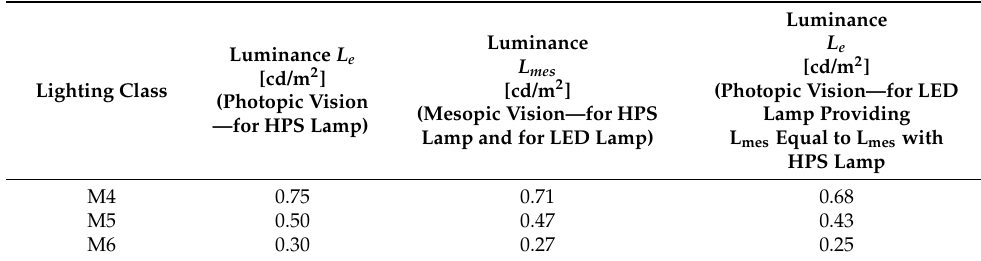
Figure 10. The human eye SPDs ratio for HPS to LED at different levels of lighting. The green line is for 0.75 cd/m 2 , black line is for 0.50 cd/m 2 , and violet line is for 0.30 cd/m 2 luminance. Table 5. Average luminance levels for different lighting classes, with the observer’s eye adjusted to different lighting conditions (photopic/mesopic vision).